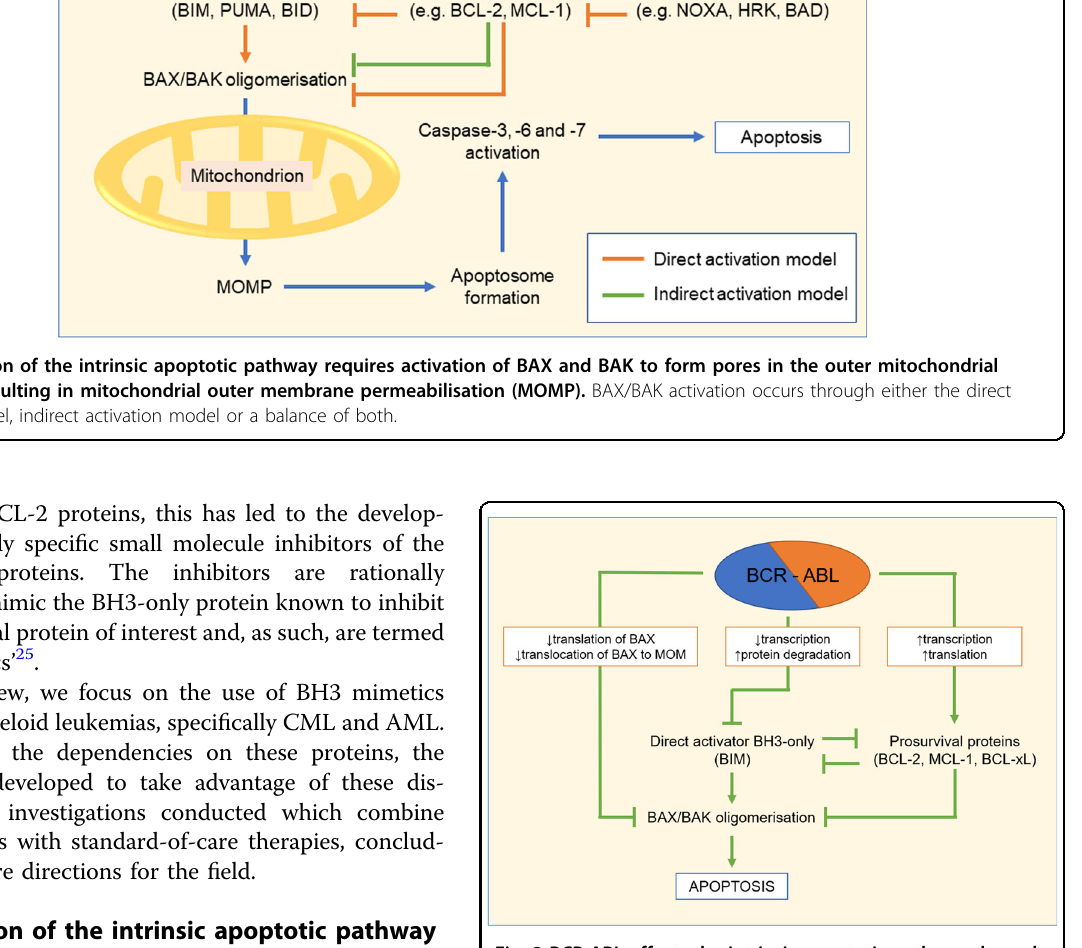
Fig. 3 BCR-ABL affects the intrinsic apoptotic pathway through upregulation of prosurvival and downregulation of proapoptotic proteins. Targeting of these protein results in a shift away from apoptosisin CML cells. Black arrows indicate BCR-ABL-mediated up- or